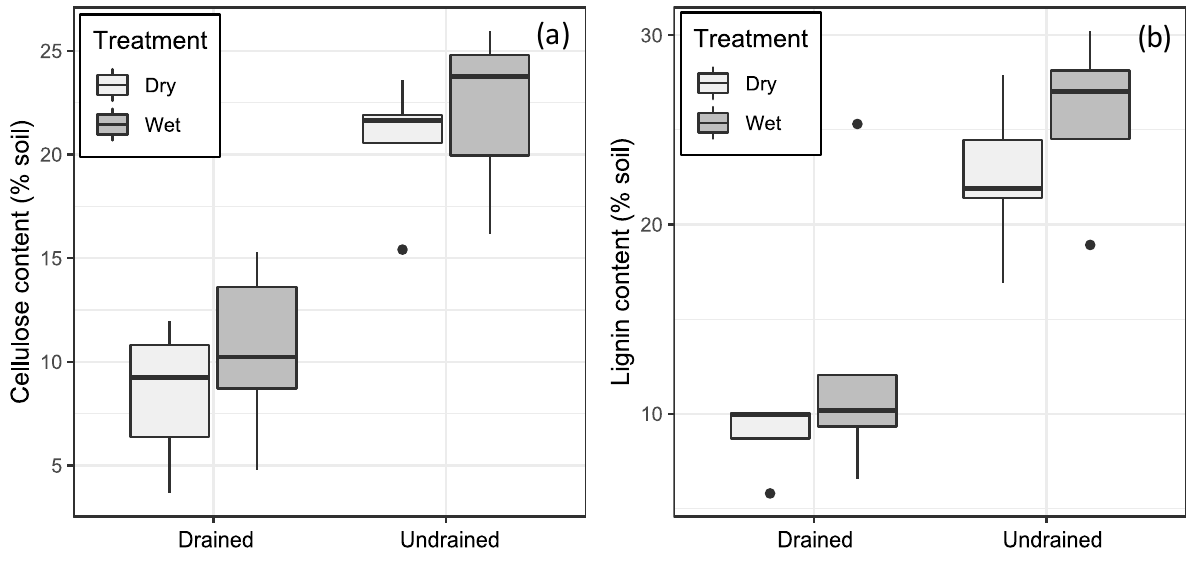
Figure 1. Properties of 20 peat monoliths collected in two fen sites with different drainage histories (historically “drained” or “undrained”), after being experimentally exposed to two water level treatments (“wet” or “dry”, i.e. water levels at 0 cm and 15 cm below the peat surface). Peat properties were characterised by (a) cellulose content and (b) lignin